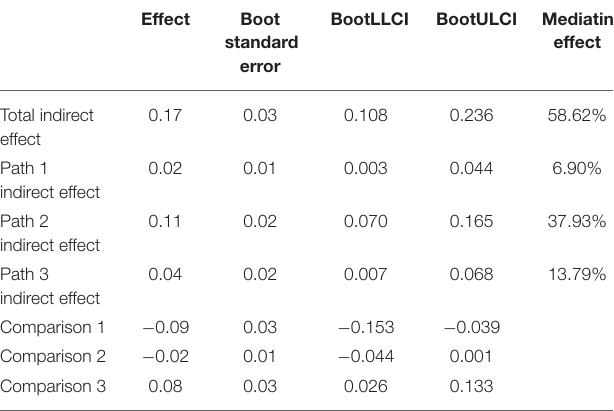
TABLE 5 | Serial mediating effect test and comparison results of different